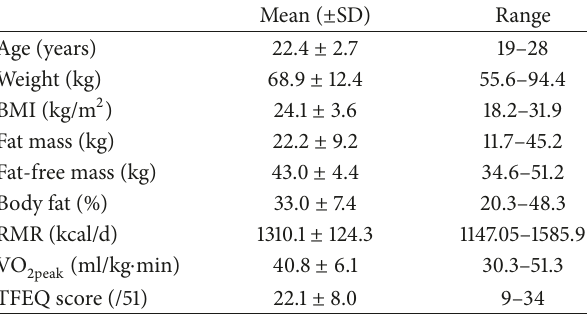
Table 2: Participants characteristics at baseline (𝑁 = 14)